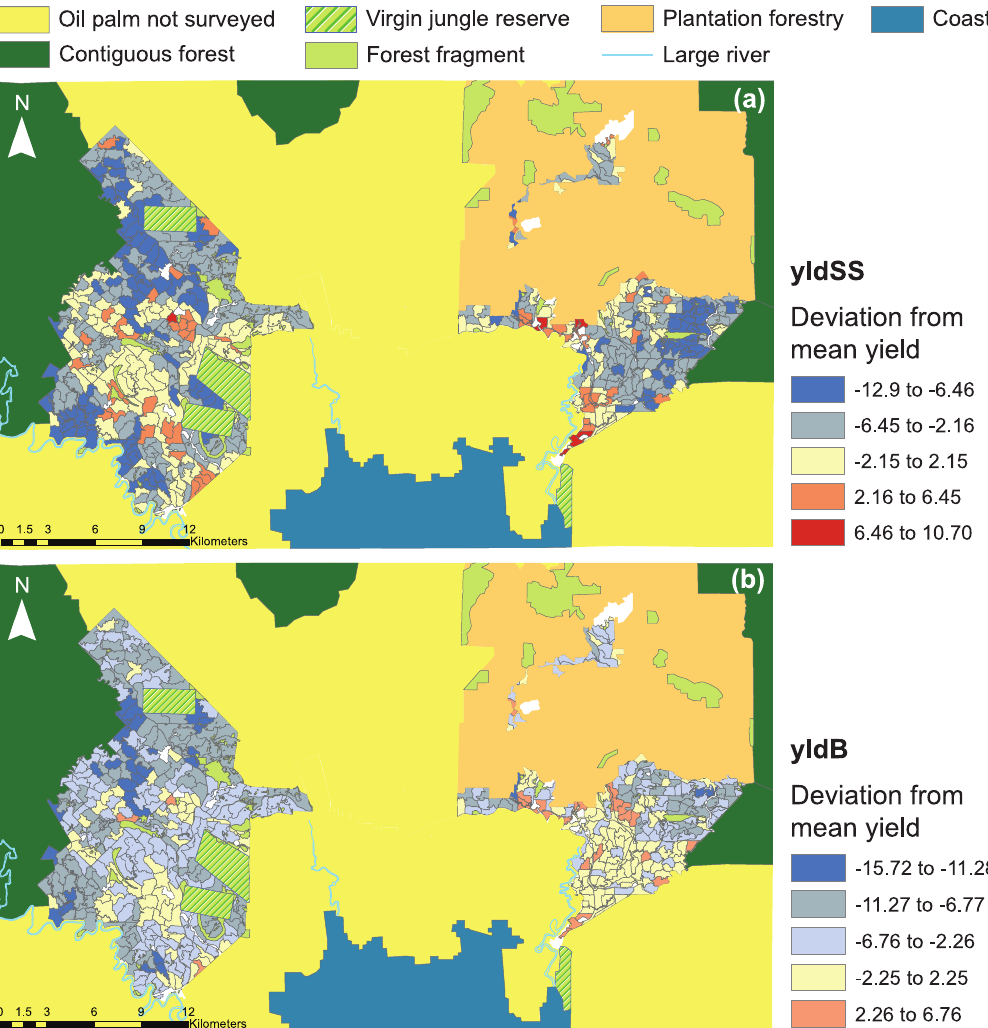
Figure 2. The variation in oil palm yield with adjacent land-uses across the study area. Oil palm yield is measured as the mean deviation from yield-by-age curves (a) generated from the study area data (yldSS), and (b) published by Butler et al. [47] (yldB). Yield is quantified as the fresh fruit bunch weight per hectare (mt ha 2 1 ).